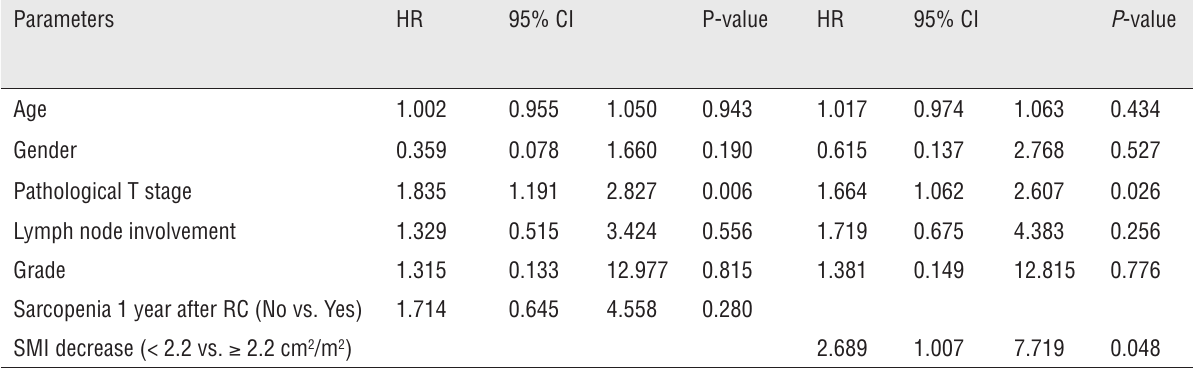
Table 3 - Multivariable Cox regression analysis of factors predicting overall death in patients with bladder cancer after radical cystectomy.